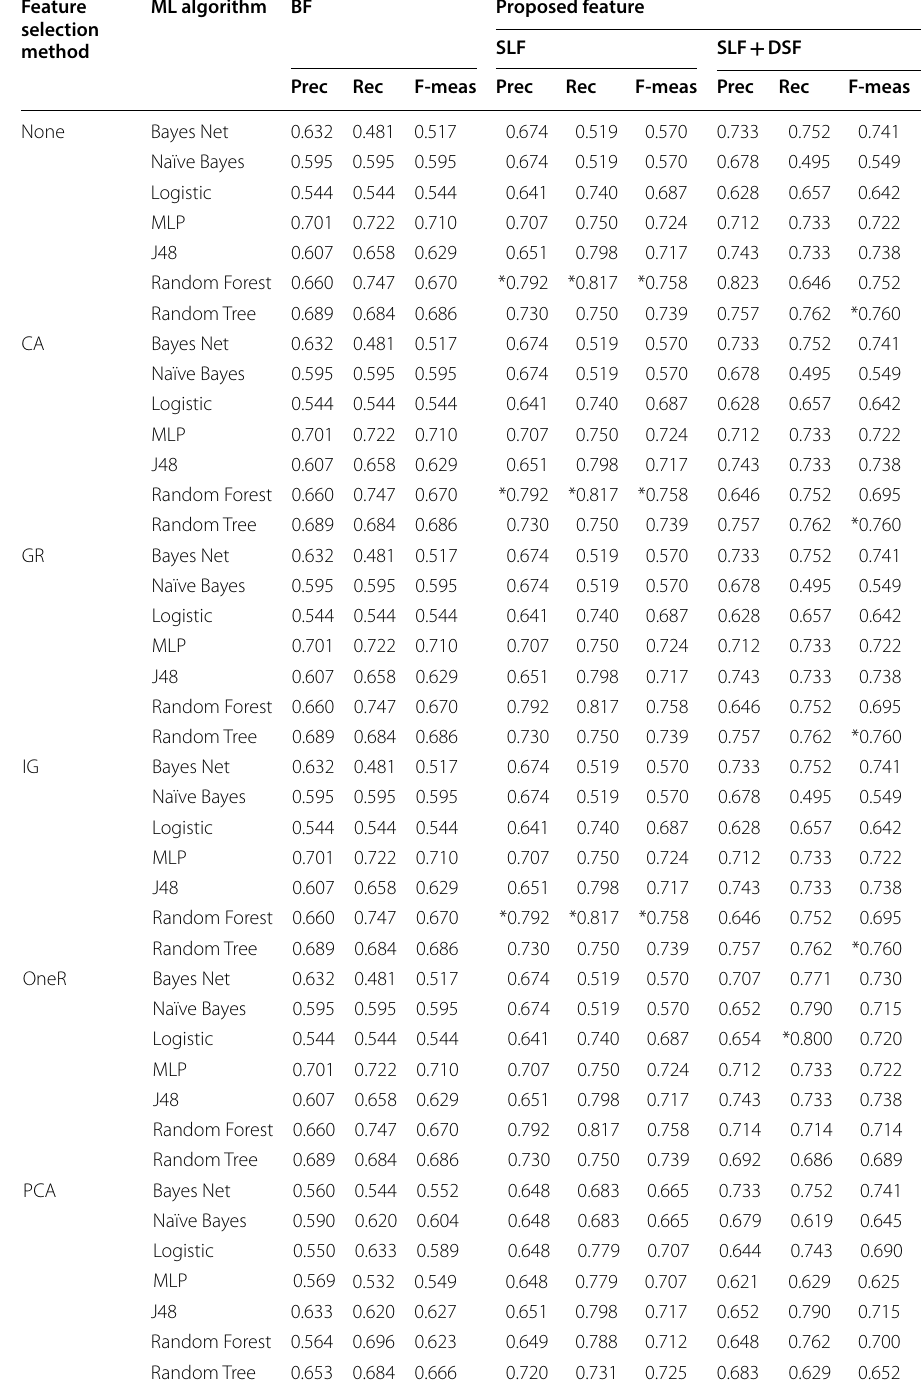
Table 8 Result of the experiment using electronics dataset Feature